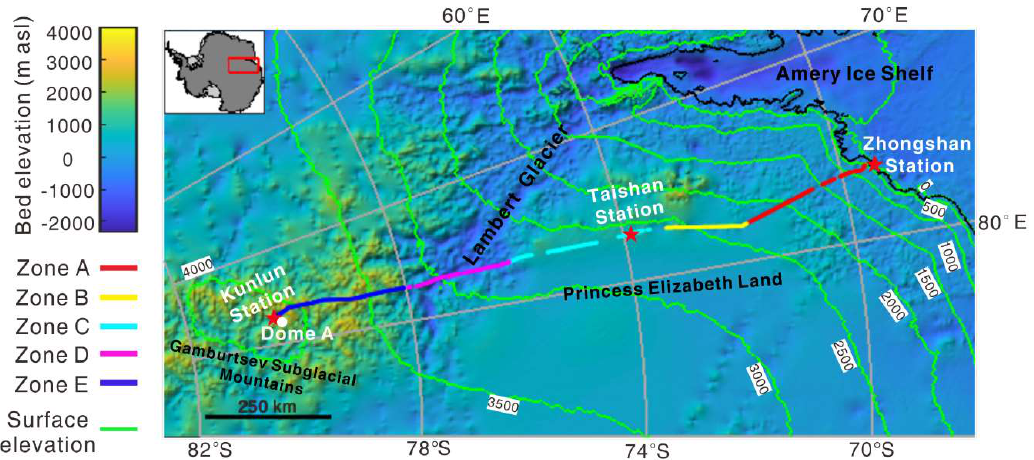
Figure 1. Map of the transect from Zhongshan to Dome A, East Antarctica. All of the bed elevation (the background image), surface elevation (the green line), and grounding line (the black line) are from Bedmap2 [40,41]. The red stars represent the locations of Zhongshan Station, Taishan Station, and Kunlun Station, respectively. The white point marks the location of Dome A.